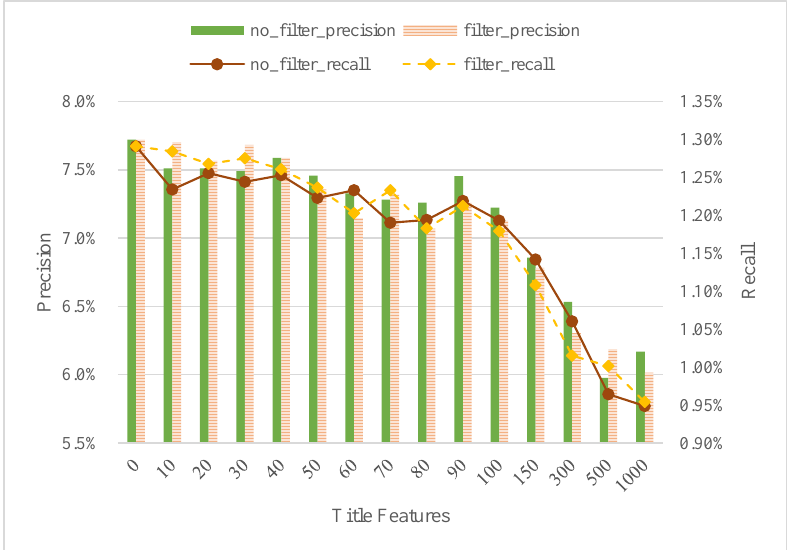
Figure 3. Precision and recall comparison with and without filtering title terms for different amount of title